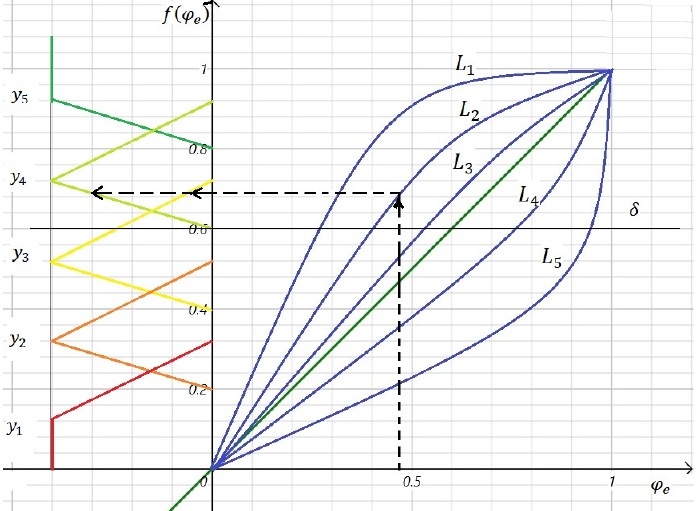
Figure 2. Graphic interpretation of the model M A ( y —levels of decision-making; L —expert opinion; ϕ e —initial estimates; f ( ϕ e ) —aggregate normalized estimate; δ —degree of decision